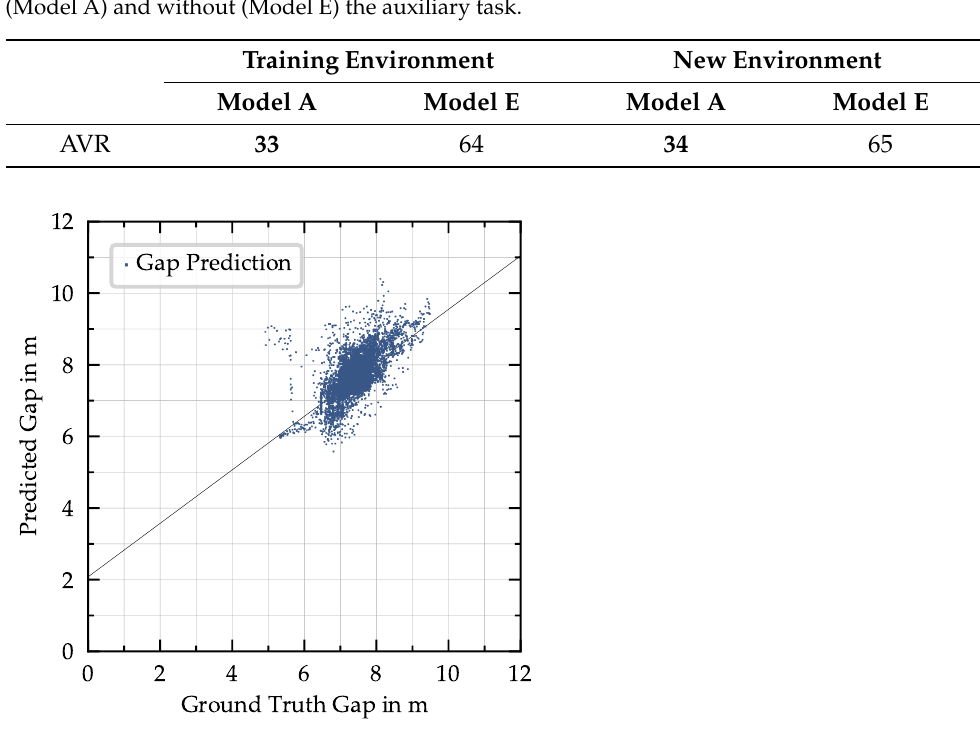
Figure 9. Accuracy of the gap prediction. Every point is a gap prediction captured on a single route, with 14,400 predictions in total. The solid black line indicates the linear regression of all